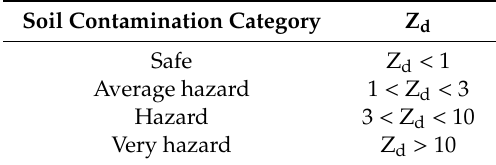
Table 1. Soil contamination on chemical substance evaluation